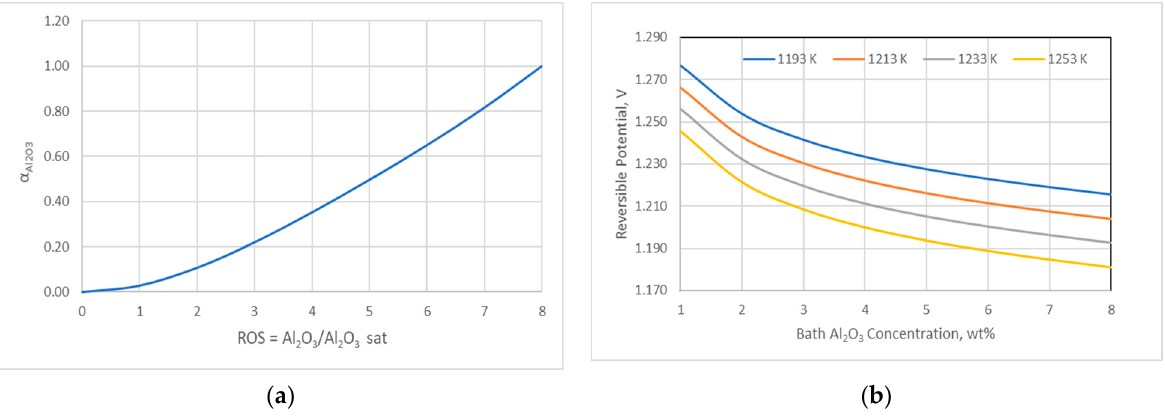
Figure 3. ( a ) Alumina activity as a function of bath alumina saturation; ( b ) Effect of temperature and alumina concentration on the cell reversible potential.